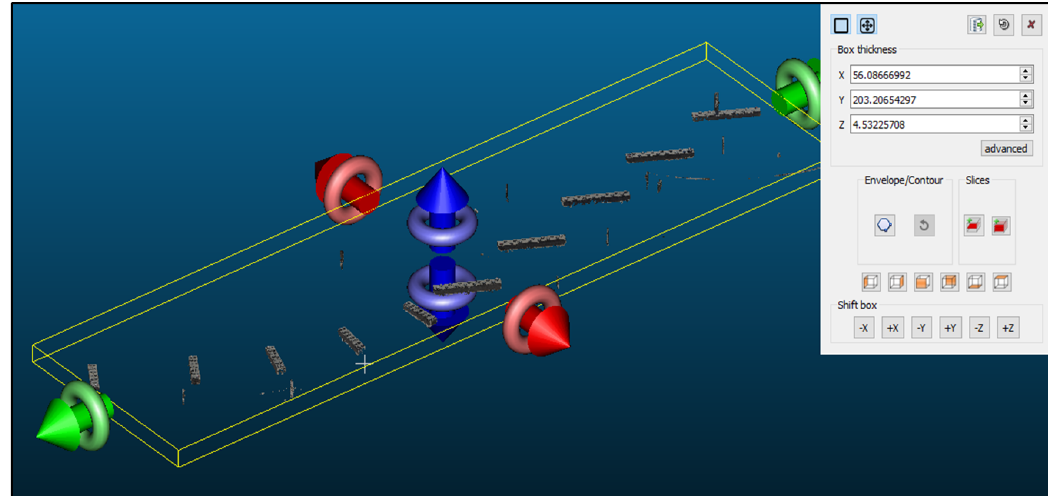
Figure 3. Pier caps segmentation.